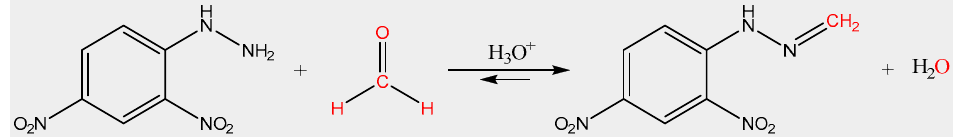
Scheme 1. Derivatization of formaldehyde by 2,4-DNPH. The red color is used to visualize the condensation site of the methyl moiety of formaldehyde within the FA-hydrazone molecule.